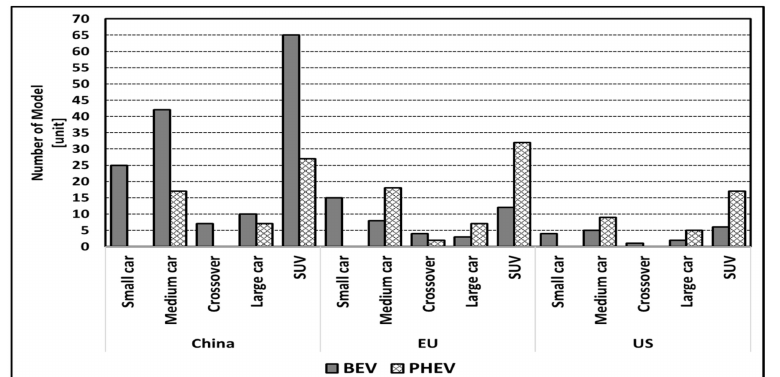
Figure 5. The number of available EV models by